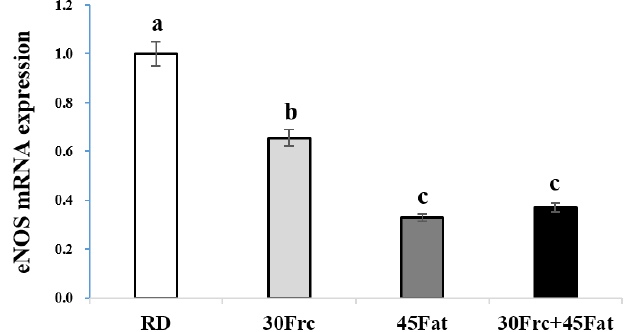
Figure 3. Aortic eNOS mRNA expression measured by quantitative real ‐ time polymerase chain